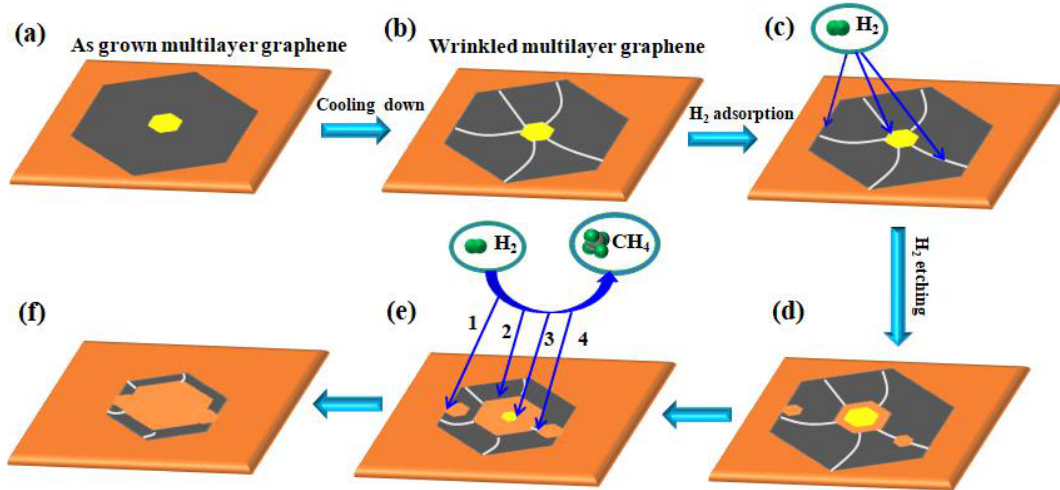
Figure 6. The schematic diagram for the growth and etching of the wrinkled multilayer graphene domain. ( a ) The multilayer graphene domain was grown on a polished Cu surface. ( b ) Formation of wrinkles under fast cooling condition. ( c ) H 2 chemisorbed on the energy unstable sites. ( d – f ) Etching generated and propagated through four pathways: (1) exterior edges of the monolayer graphene; (2) interior edges of the monolayer graphene; (3) edges of the multilayer graphene; (4) wrinkled sites.